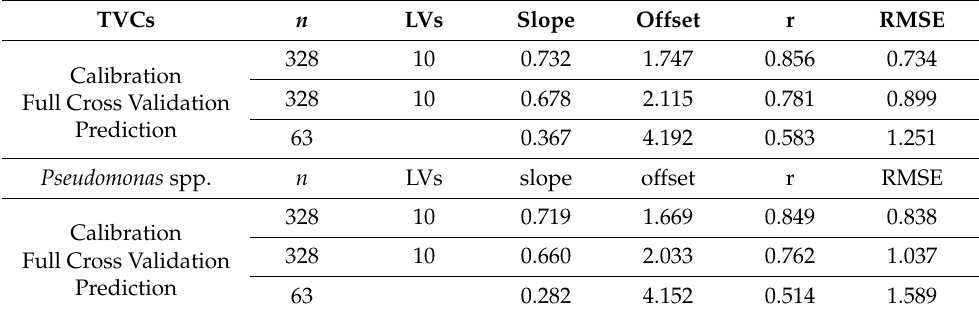
Table 3. Performance metrics of the developed PLS-R models estimating TVCs and Pseudomonas spp. counts of chicken thigh samples via FT-IR spectral data analysis.